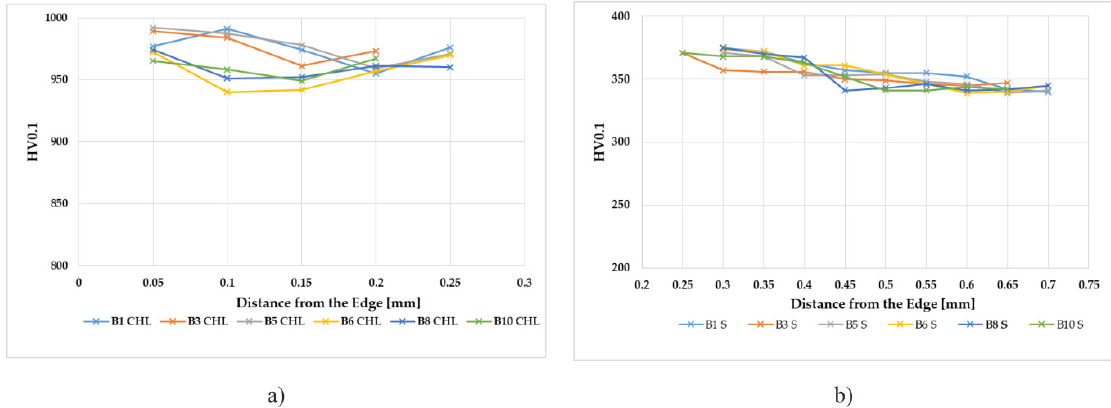
Figure 7. The course of microhardness in samples B1 to B10, ( a ) microhardness in the chrome layer, CHL = chrome layer; ( b ) microhardness in the substrate, S = substrate.